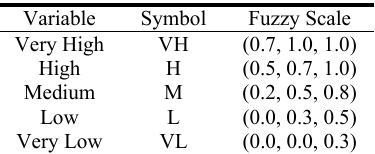
Table 1. Linguistic variables for rating